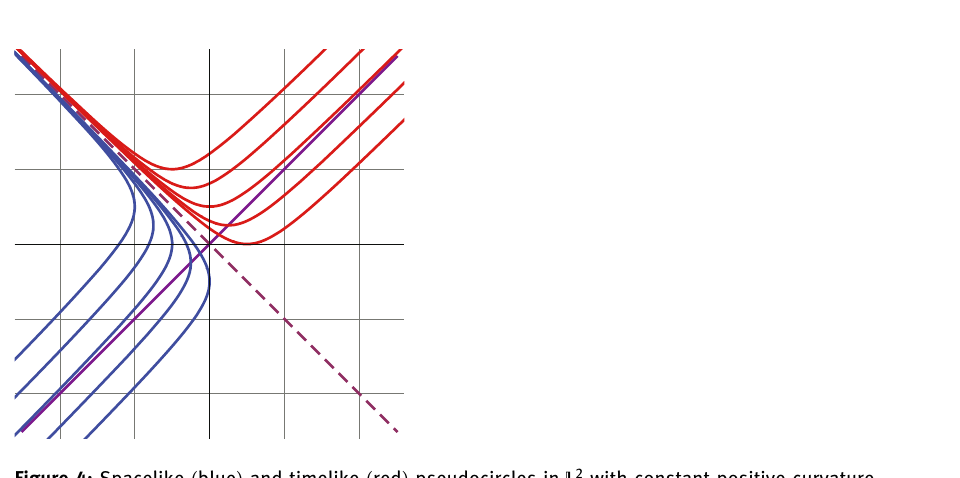
Figure 4: Spacelike ( blue ) and timelike ( red ) pseudocircles in (cid:2) 2 with constant positive